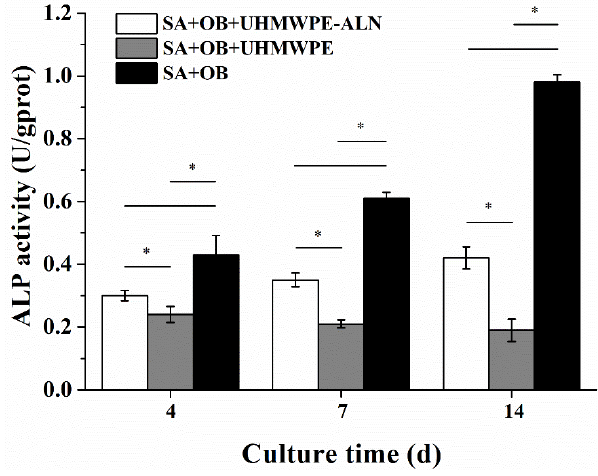
Figure 6. The ALP activities of osteoblasts after being co-cultured with critical-sized UHMWPE- ALN wear particles in cell reactors for 4, 7, and 14 d ( n = 3, * p < 0.05).